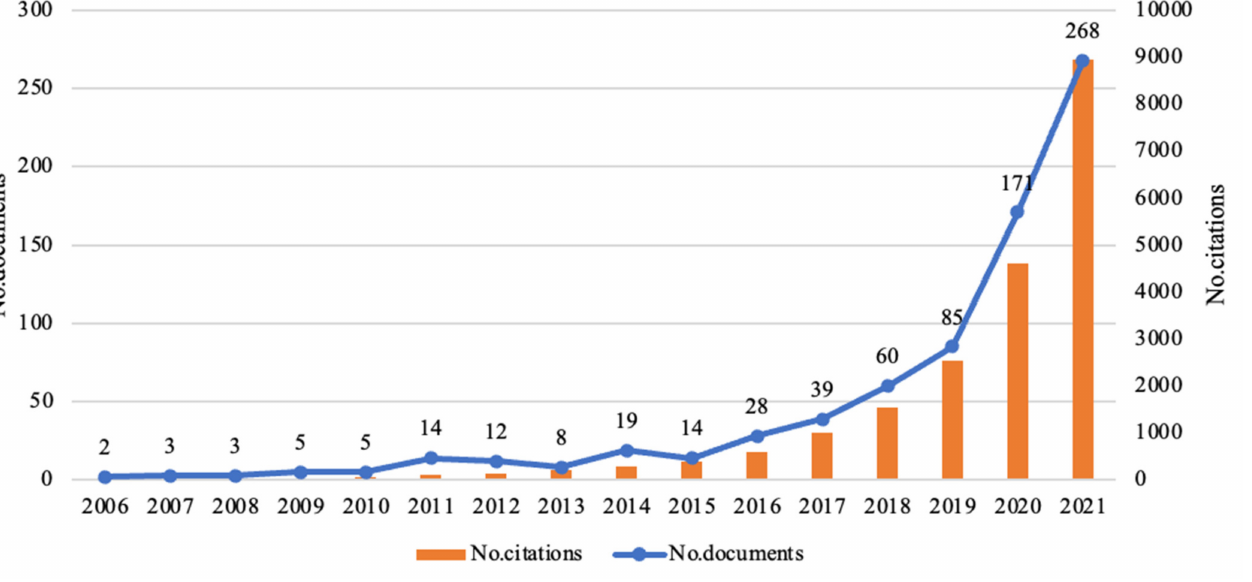
Figure 4. The dynamics of publication activity and citations for the analyzed publications (based on the Scopus data, October